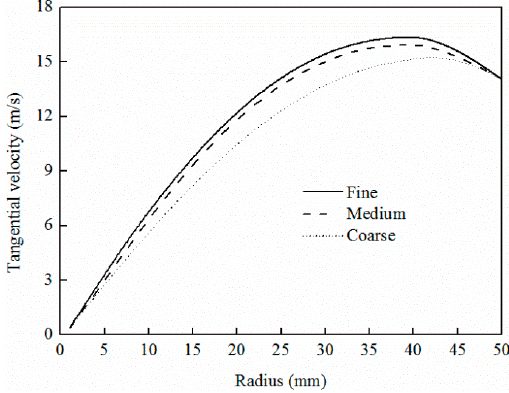
Figure 5. Comparison between different mesh resolutions.